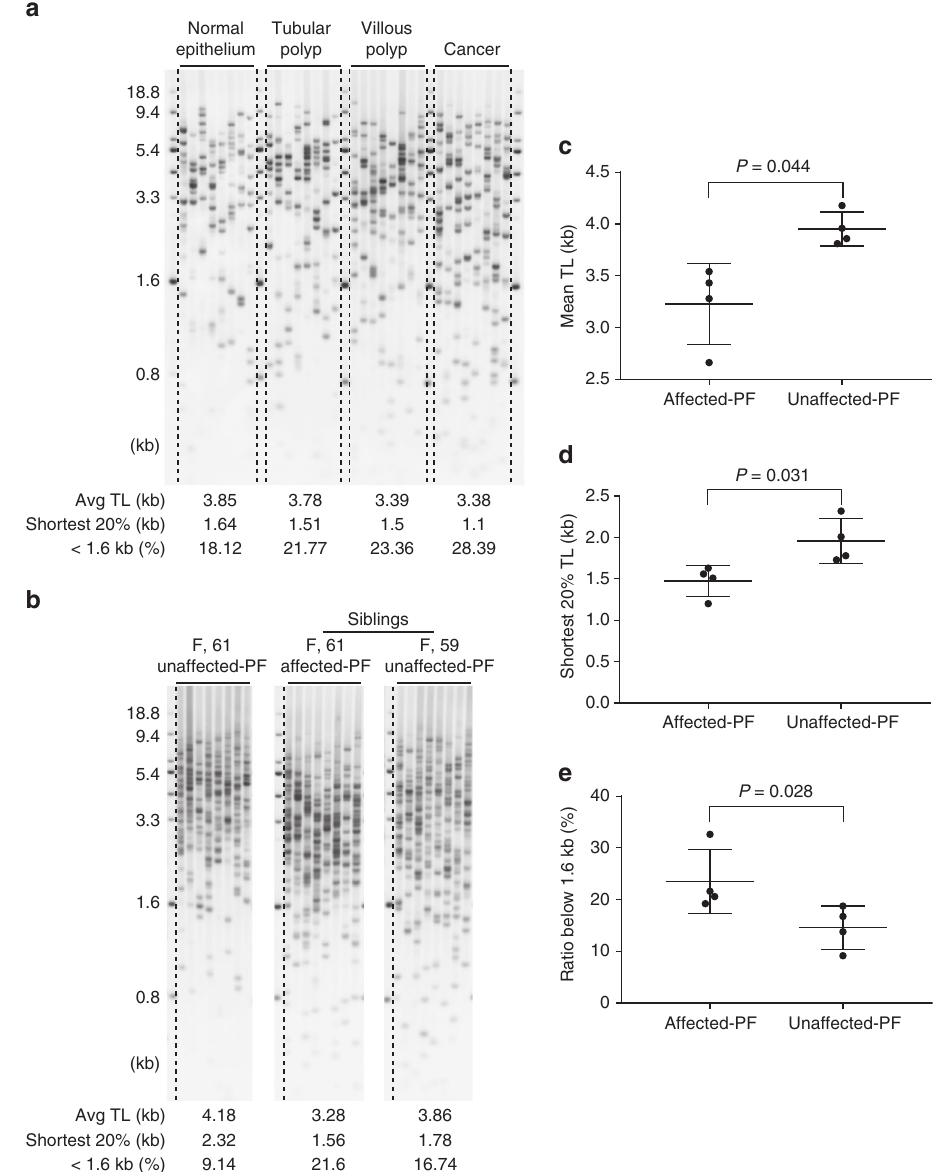
Fig. 5 Using TeSLA to determine TL and distribution of telomeres in colon cancer progression and idiopathic pulmonary fi brosis (IPF) siblings compared to age-matched normal controls. a TeSLA results of normal colorectal epithelium, adenomas (tubular polyp and villous polyp), and colon cancer tissues from one colon cancer patient show shorter mean TL and increasing amount of the shortest telomeres in adenomas and cancer tissues compared to normal colorectal epithelium. b Using TeSLA to determine TLs of DNA isolated from circulated leukocytes of the unrelated normal control, siblings with and without IPF. The age and gender are indicated above each TeSLA results. c – e Scatter plots of mean TL of TeSLA ( c ), the shortest 20% of telomeres ( d ), and percent of the shortest TL ( < 1.6 kb) (e) are shown for family members that have no IPF (three unrelated controls and a family member without IPF) and four family members with IPF. ( c – e mean and s.e.m., n =